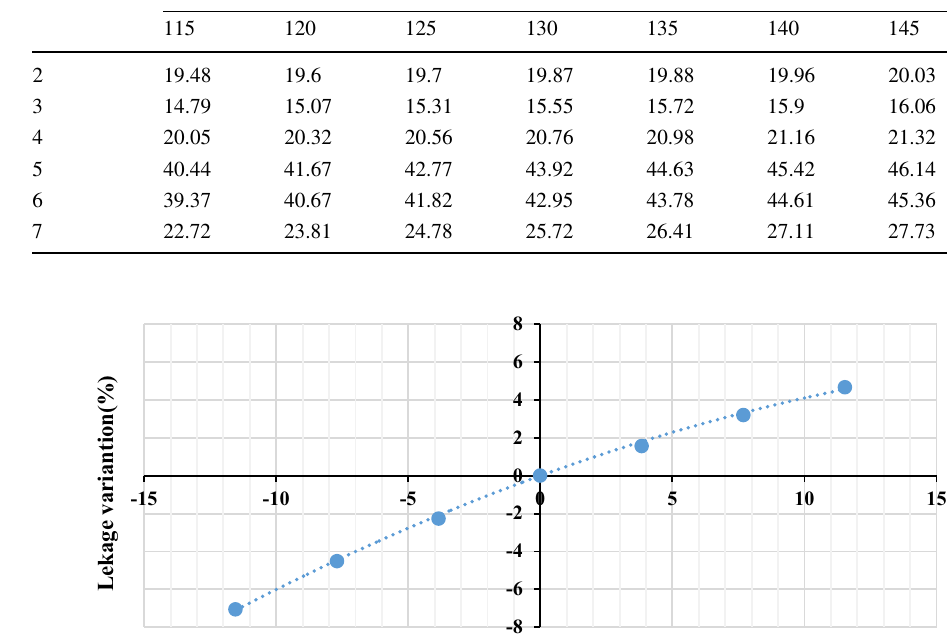
Table 12 Variation in Hazen– Williams coefficient on pressure-dependent leakage (m3/hr) in two-loop WDN